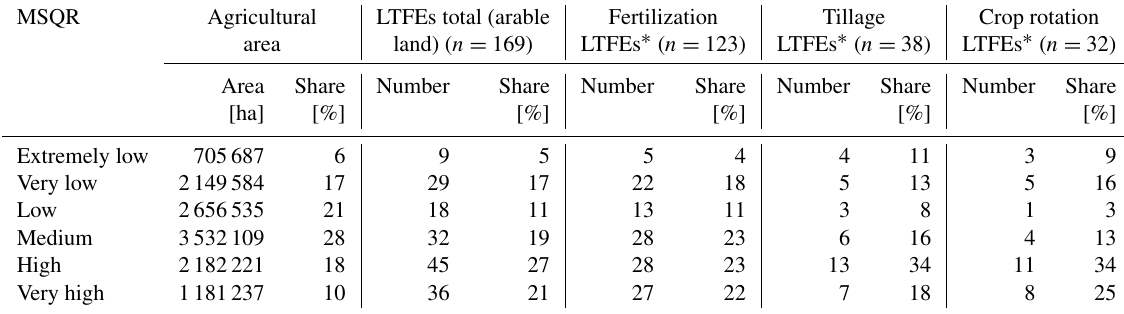
Table 4. Müncheberg Soil Quality Rating (MSQR) classification of arable land in Germany and the number and share of the different LTFE types in each MSQR class.